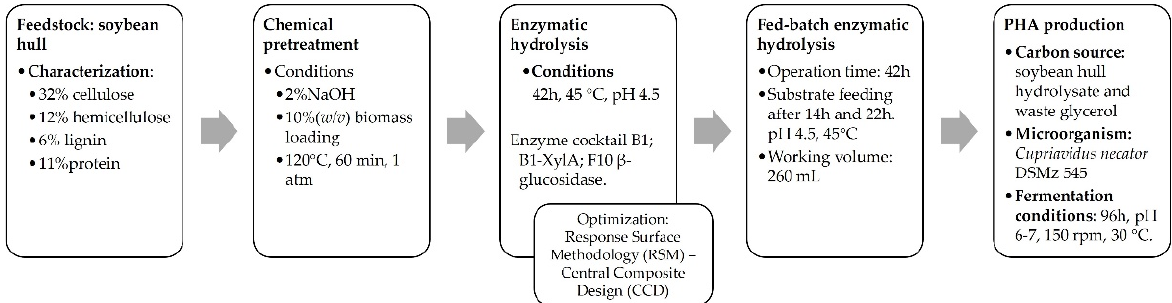
Figure 1. Stages followed for the biotechnological production of PHB through the valorization of soybean hulls and residual glycerol. soybean hulls and residual